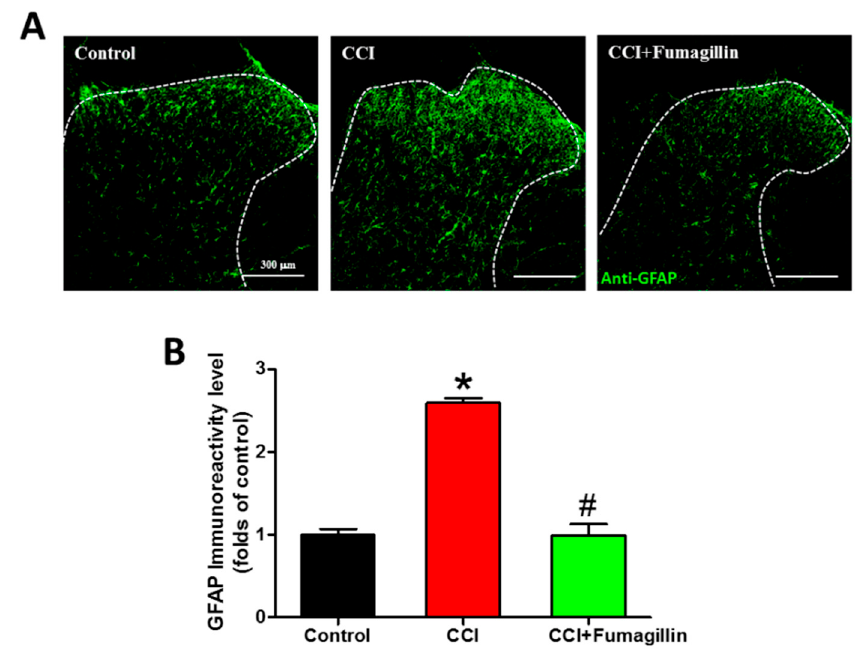
Figure 8. Effect of intrathecal administration of fumagillin on chronic constriction injury (CCI) − induced astrocytic activation. Lumbar spinal cord sections were obtained at postoperative day (POD) 14 from control, CCI, and CCI + fumagillin groups. ( A ) Immunofluorescence images show cells labeled with glial fibrillary acidic protein (GFAP , green) in the ipsilateral spinal cord dorsal horn (20 − µm sections; magnification: 100× scale bars: 300 µm). ( B ) The quantification of GFAP immunoreactivity was expressed as mean ± standard error of mean (SEM) (4 sections per rat, 3 rats per group). Treatment with fumagillin (intrathecal) significantly inhibited CCI − upregulated GFAP immunoreactivity. * p < 0.05 compared with the control group; # p < 0.05 compared with the CCI group; one-way analysis of variance (ANOVA) with post hoc Tukey